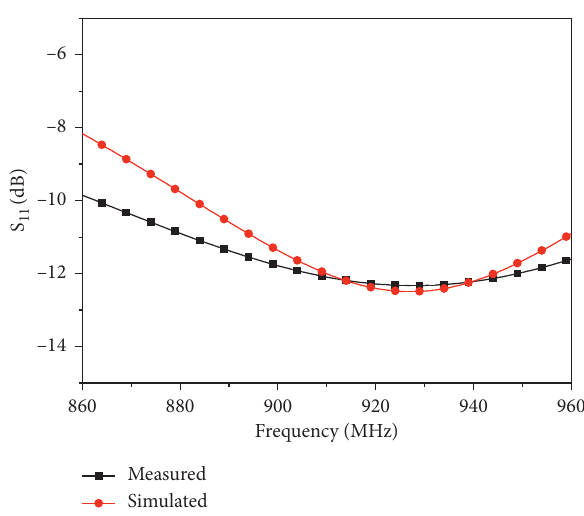
Figure 5: Simulated and measured reflection coefficients of the four-branch